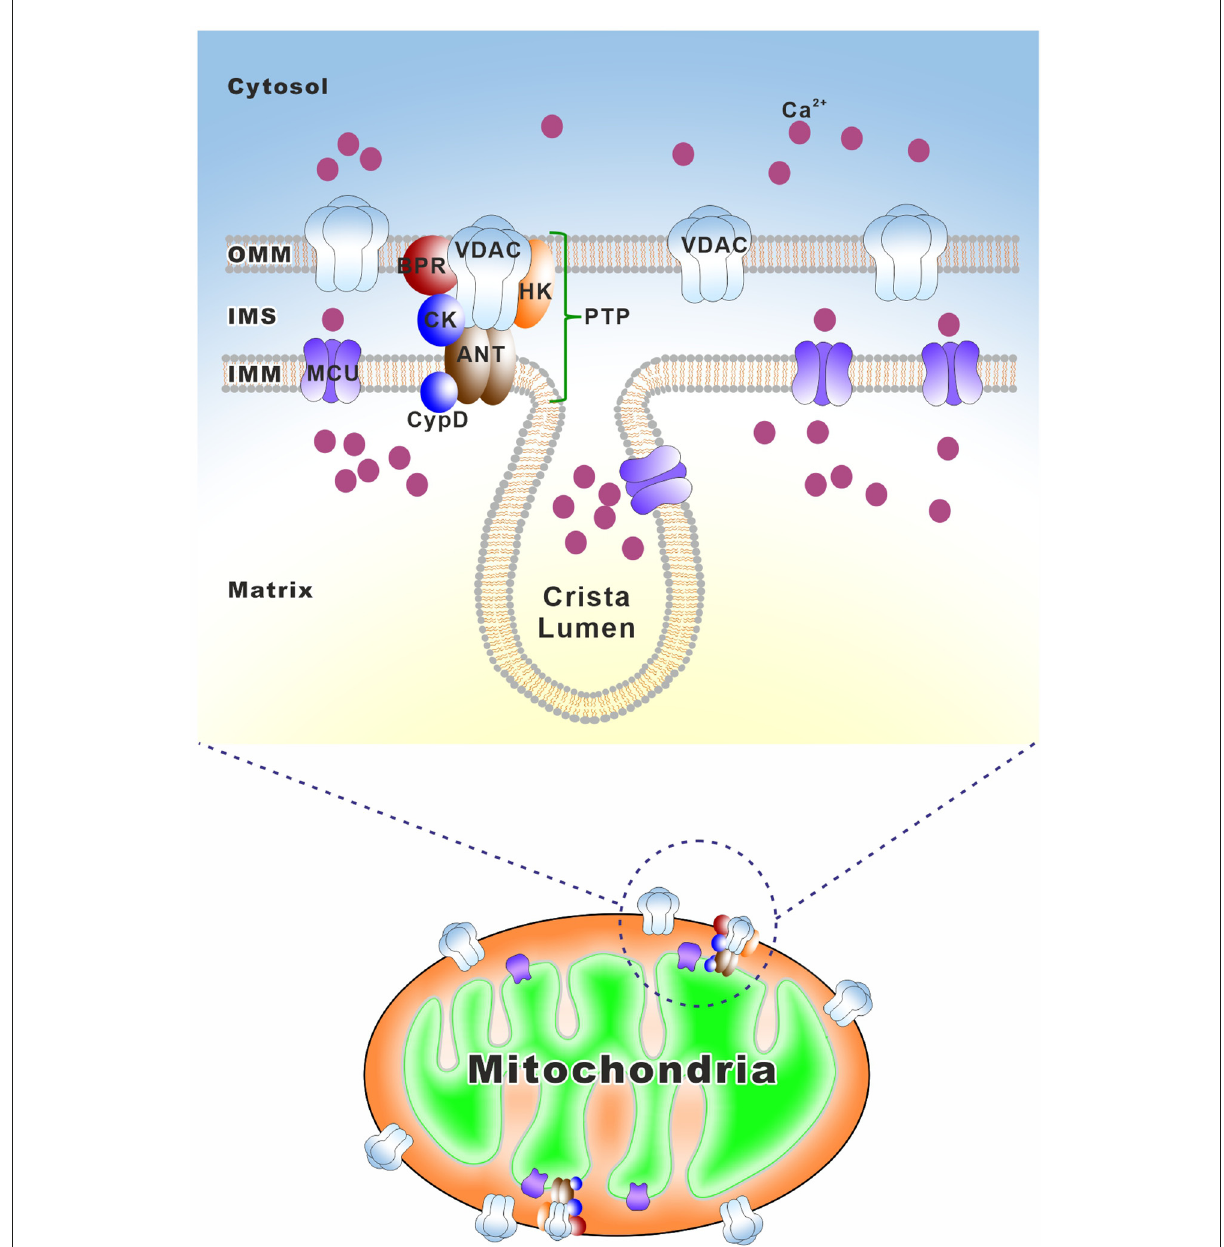
FIGURE7 Schematic overview of mitochondrial ion channels that are implicated in neurodegeneration. Mitochondrial ion channels are a group of integral membrane proteins mediating ionic fluxes across the mitochondrial membranes. VDAC is a voltage-dependent anion channel residing in the OMM and MCU is a mitochondrial calcium uniporter in the IMM. PTP is a mitochondrial permeability transition pore that allows mitochondria to undergo a sudden increase of permeability, including VDAC in the OMM and the adenine nucleotide translocase (ANT) in the IMM. Cyclophilin D (CypD) in the matrix is a sensitizer of PTP. Peripheral benzodiazepine receptor (BPR), hexokinase (HK), and creatine kinase (CK) are the other components of